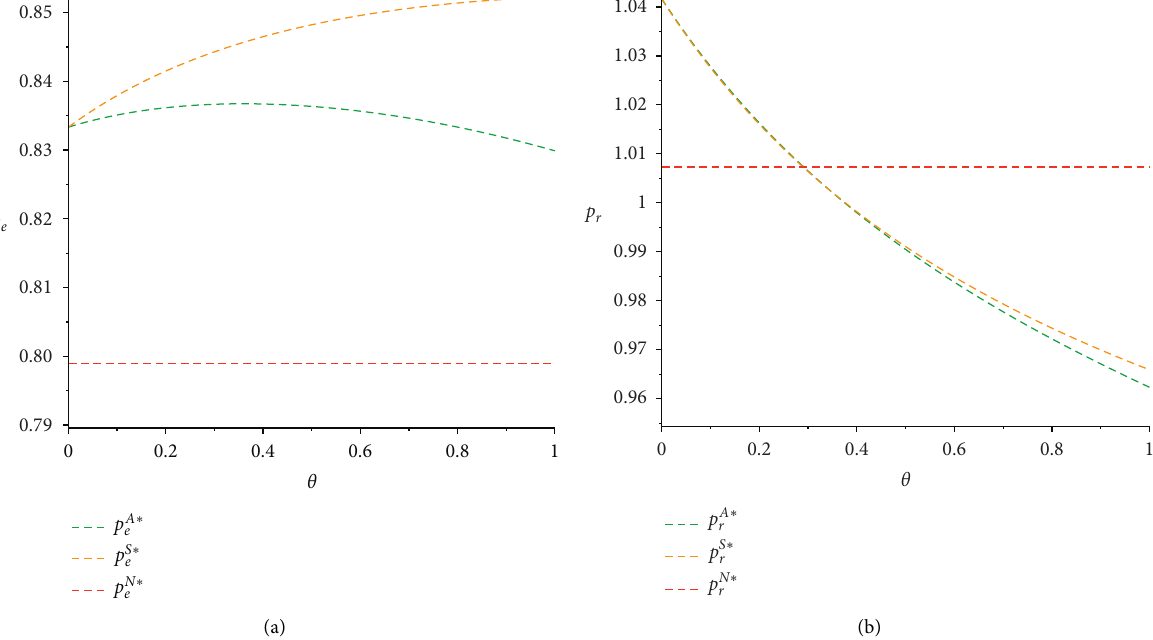
. (a) Equilibrium prices of e-tail channel under